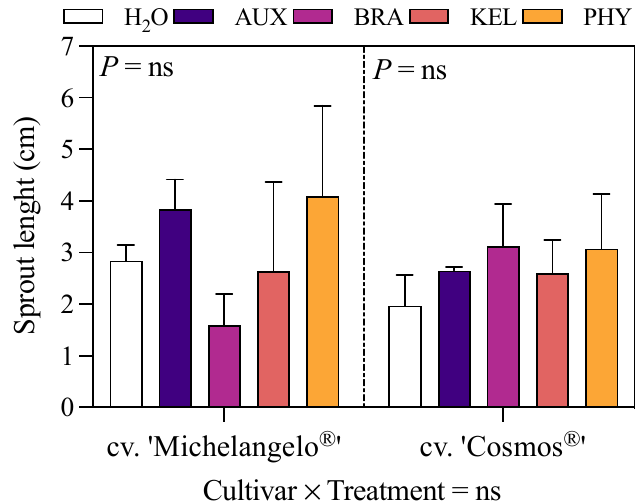
Figure 3. Sprout length of cv. ‘Michelangelo ® ’ and ‘Cosmos ® ’ cuttings, 14 weeks after the treatments. Cuttings were treated with: H 2 O = distilled water; AUX = auxins; BRA = homobrassinolide; KEL = Kelpak ® ; PHY = Phylgreen. Two-way and one-way ANOVA p -values are reported in the figure (ns, not significant).